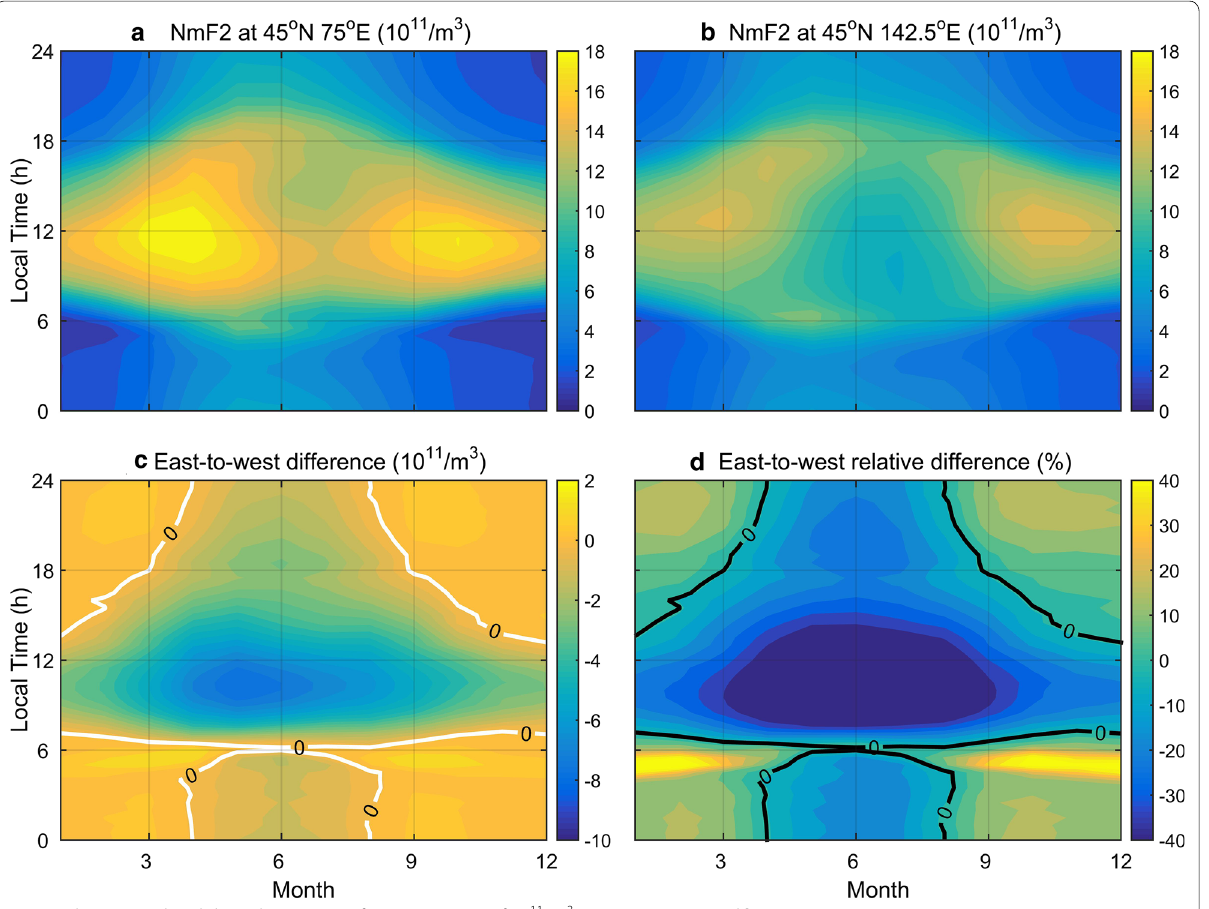
Fig. 1 The seasonal and diurnal variations of NmF2 (in units of 10 11 /m 3 ) a at 45º N 75º E and b at 45º N 142.5º E, c ΔNmF2 (NmF2 east -NmF2 west , in units of 10 11 /m 3 ), and d relative differences ( R ew , in units of %). The solid lines in these plots represent the zero